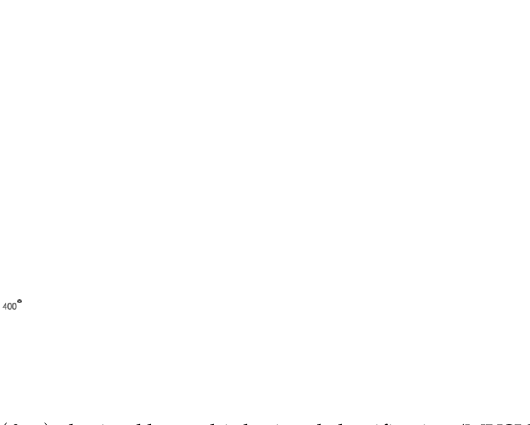
Figure 8. Example of directivity pattern D tar ( θ , φ ) obtained by multiple signal classification (MUSIC).